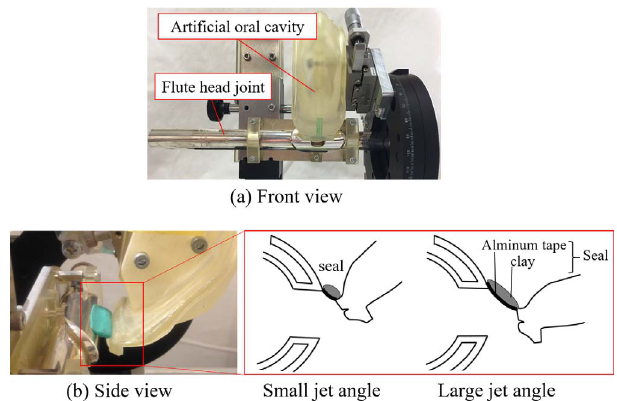
Figure 9. Experimental setup for arti fi cial